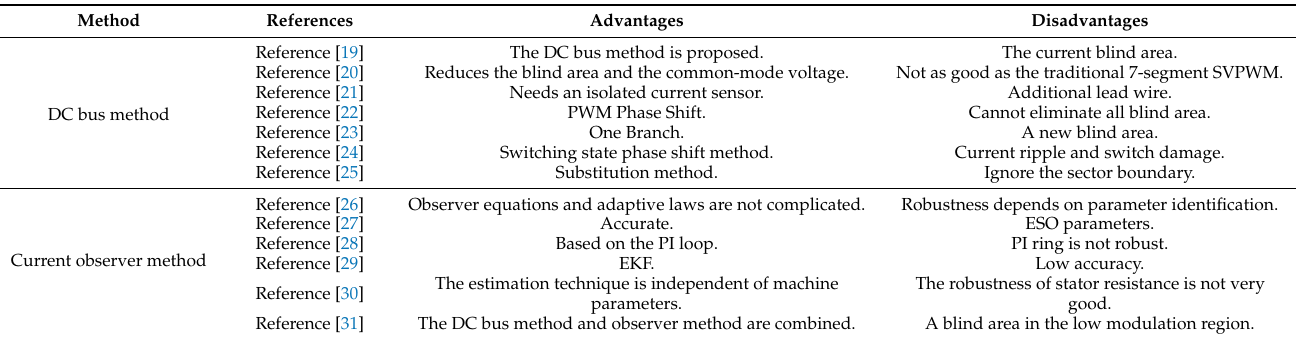
Table 1. Brief comparisons of single current control